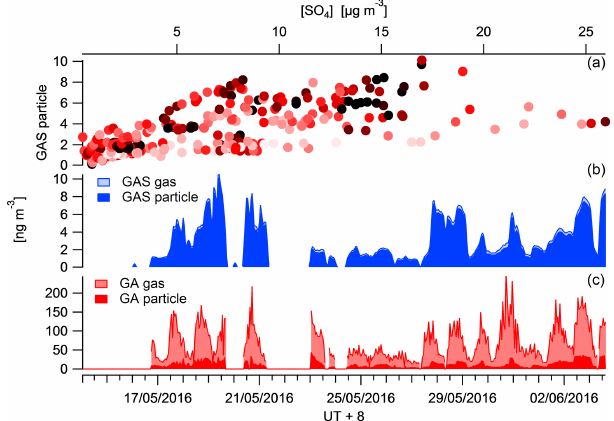
Figure 7. Campaign time series of glycolic acid (red) and GAS (blue) in the particle and gas phase. The top panel illustrates the correlation between GAS in the particle phase and SO 2 −